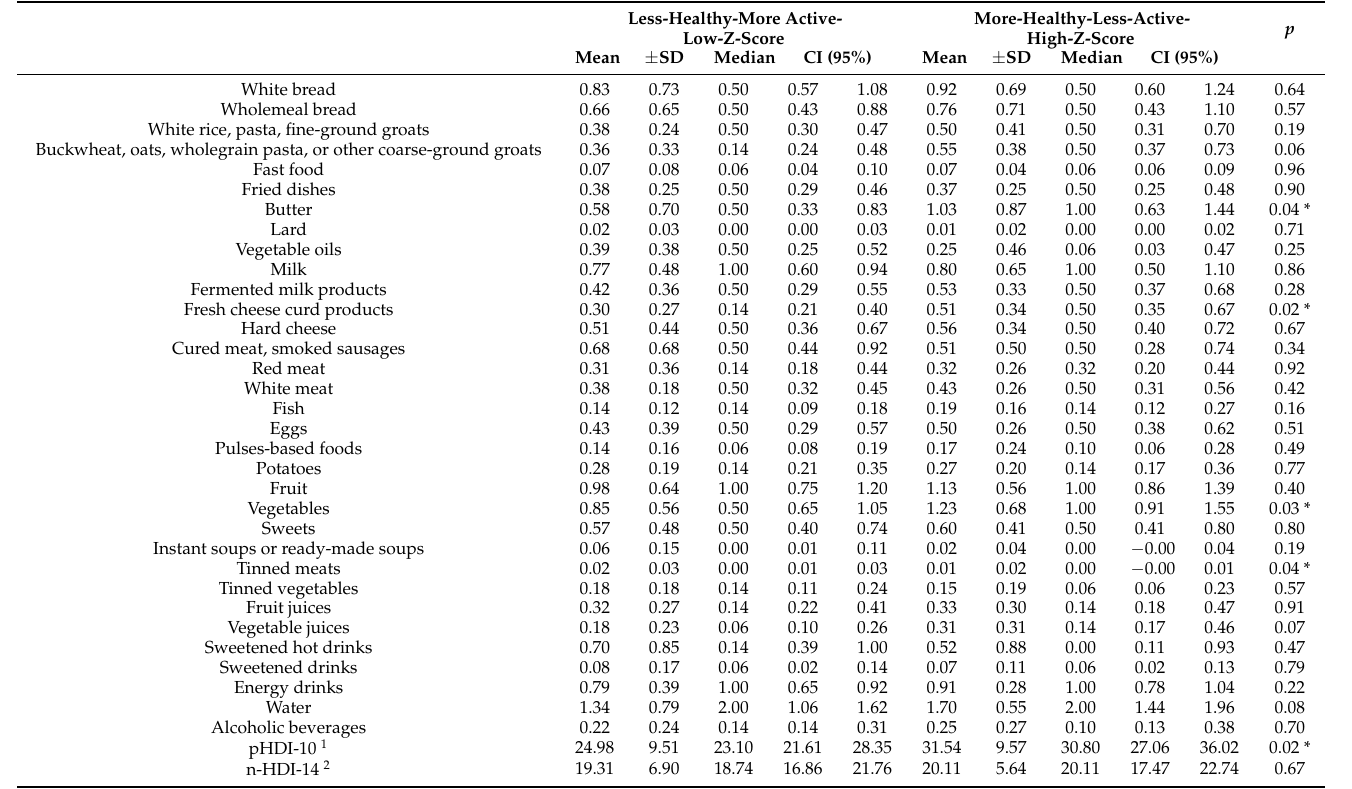
Table 3. The differences in food frequency intake per day between the Less-healthy-more-active-low- Z-score and More-healthy-less-active-high-Z-score clusters of runners. Less-Healthy-More Active- More-Healthy-Less-Active- p Low-Z-Score High-Z-Score Mean ± SD Median CI (95%) Mean ± SD Median CI (95%) White bread